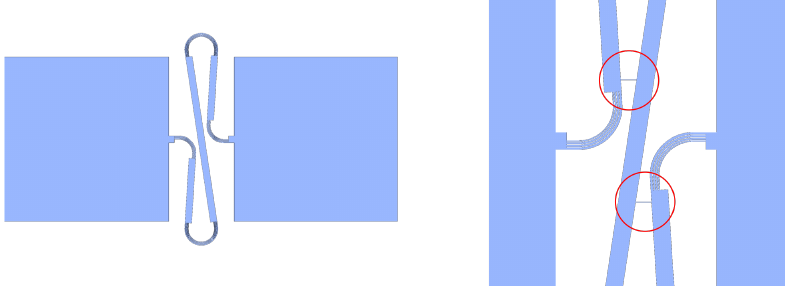
Figure 2. An interconnect connecting two nodes ( left ) and circled sacrifice bridges ( right